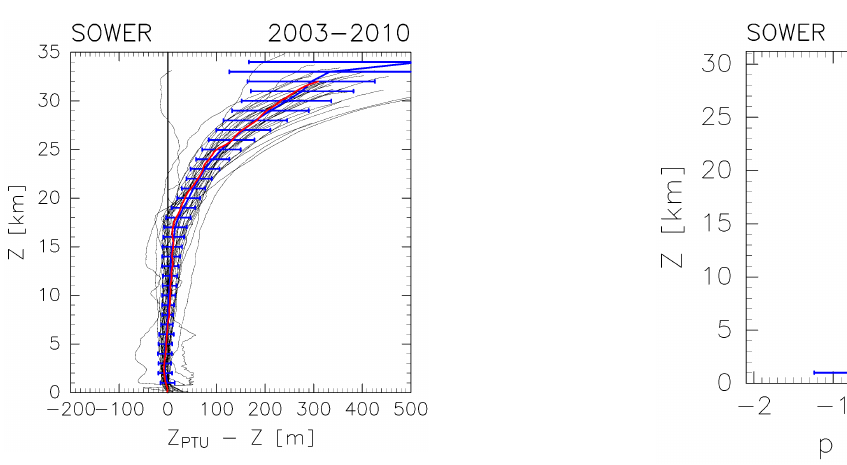
Figure 2. RS80 pressure bias estimated for all soundings listed in Table 1. Horizontal bars show 1 standard deviation. Table 1. Number of successful soundings by the SOWER campaign between December 2003 and January 2010, and the locations of campaign sites. Station Location